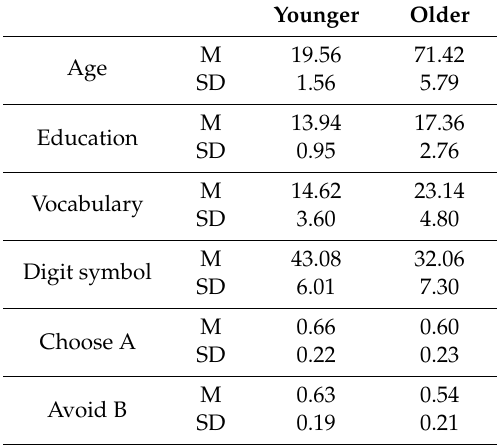
Table 1. Means (M) and standard deviations (SD) for demographic, psychometric, and test phase data for younger and older